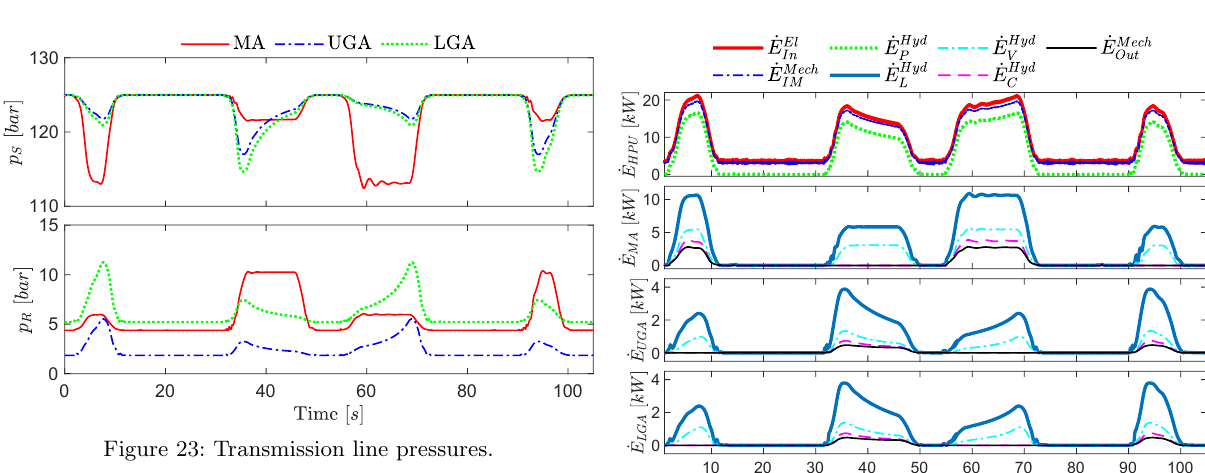
Figure 23: Transmission line pressures.